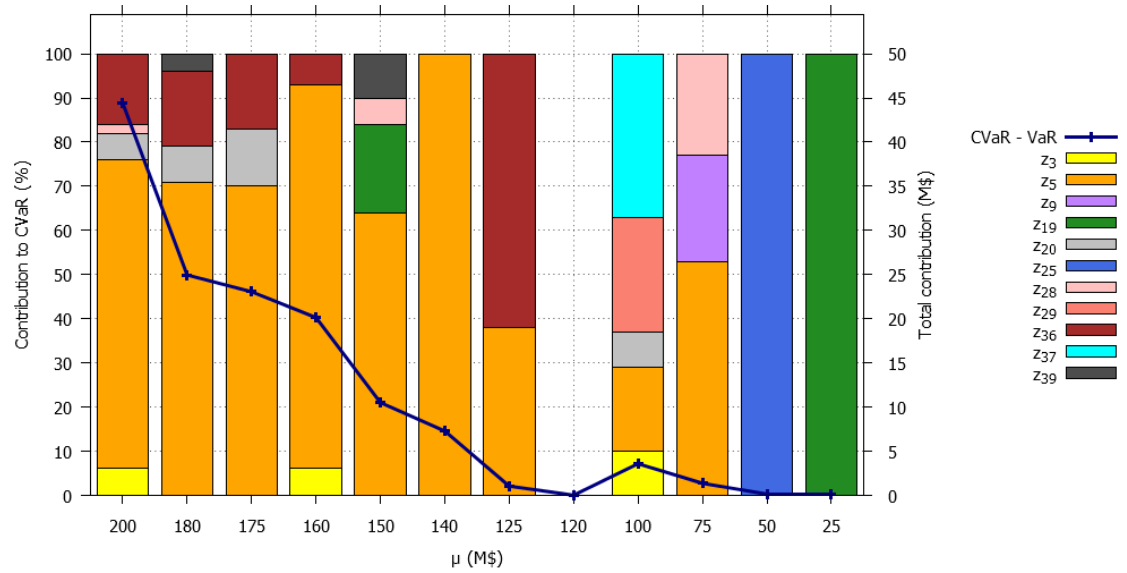
to CVaR through 𝑧𝑧 𝑟𝑟